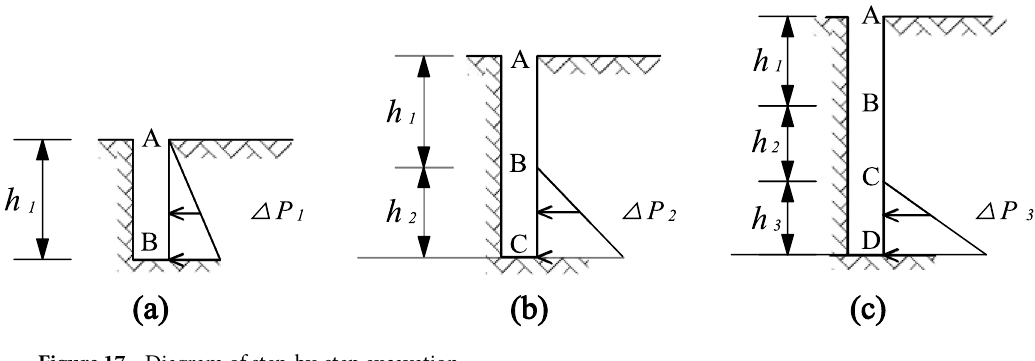
Figure 17. Diagram of step-by-step